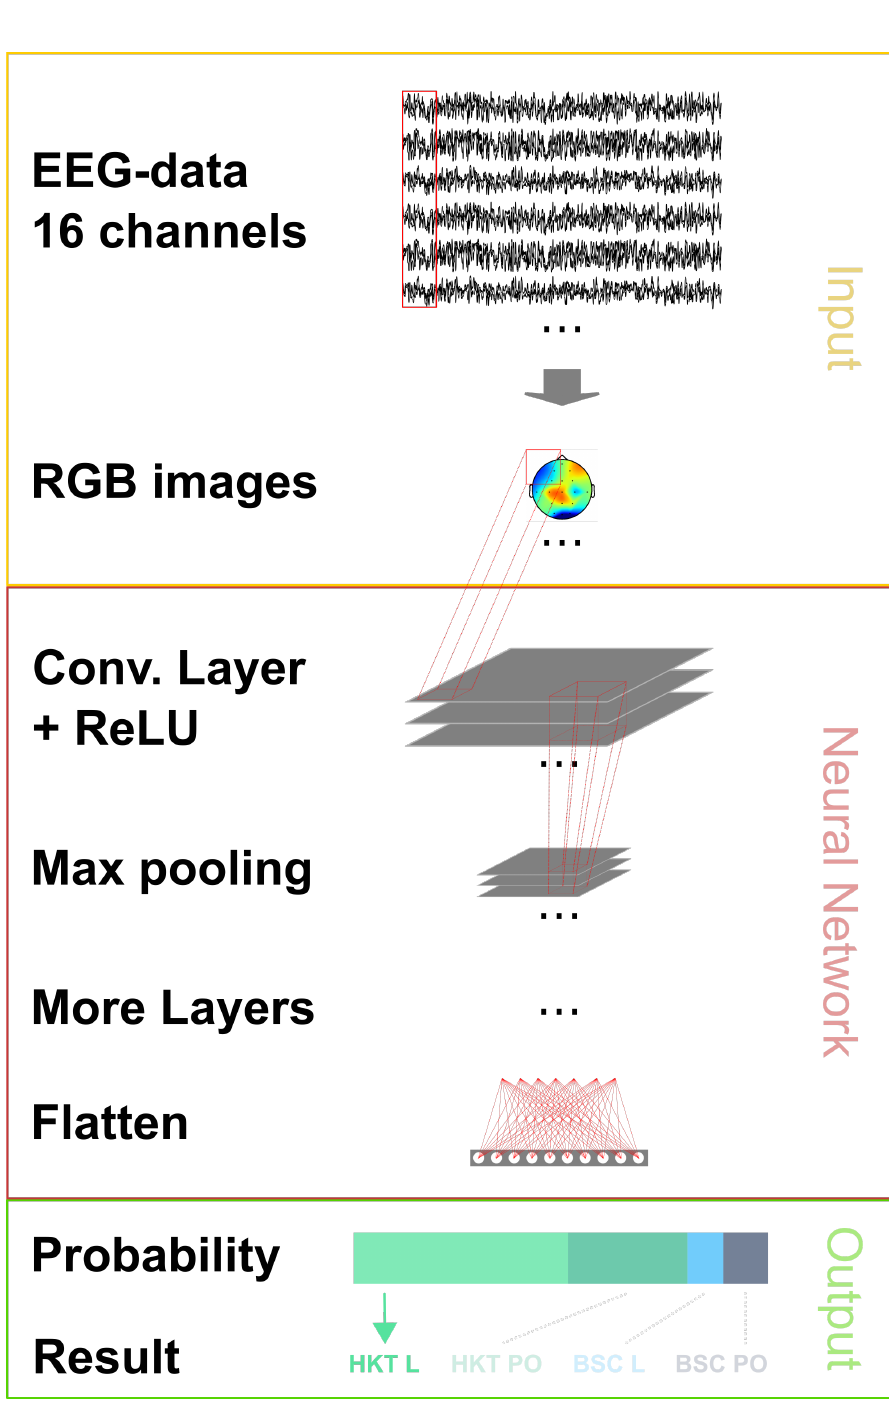
Figure 7. Deep Learning architecture for the classification of the